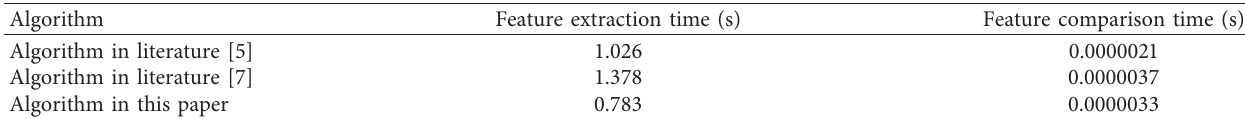
Table 3: The processing time of the three algorithms for a single